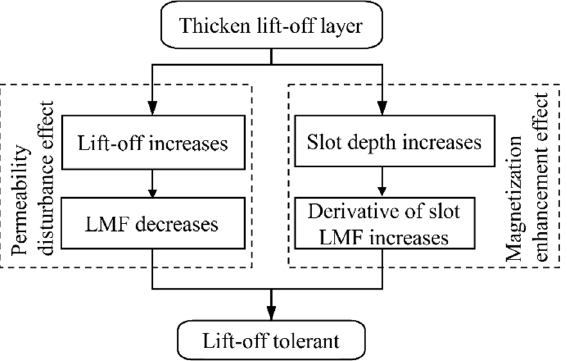
Figure 10. Schematic diagram of the lift-off tolerance of the SFLL-MFL method.